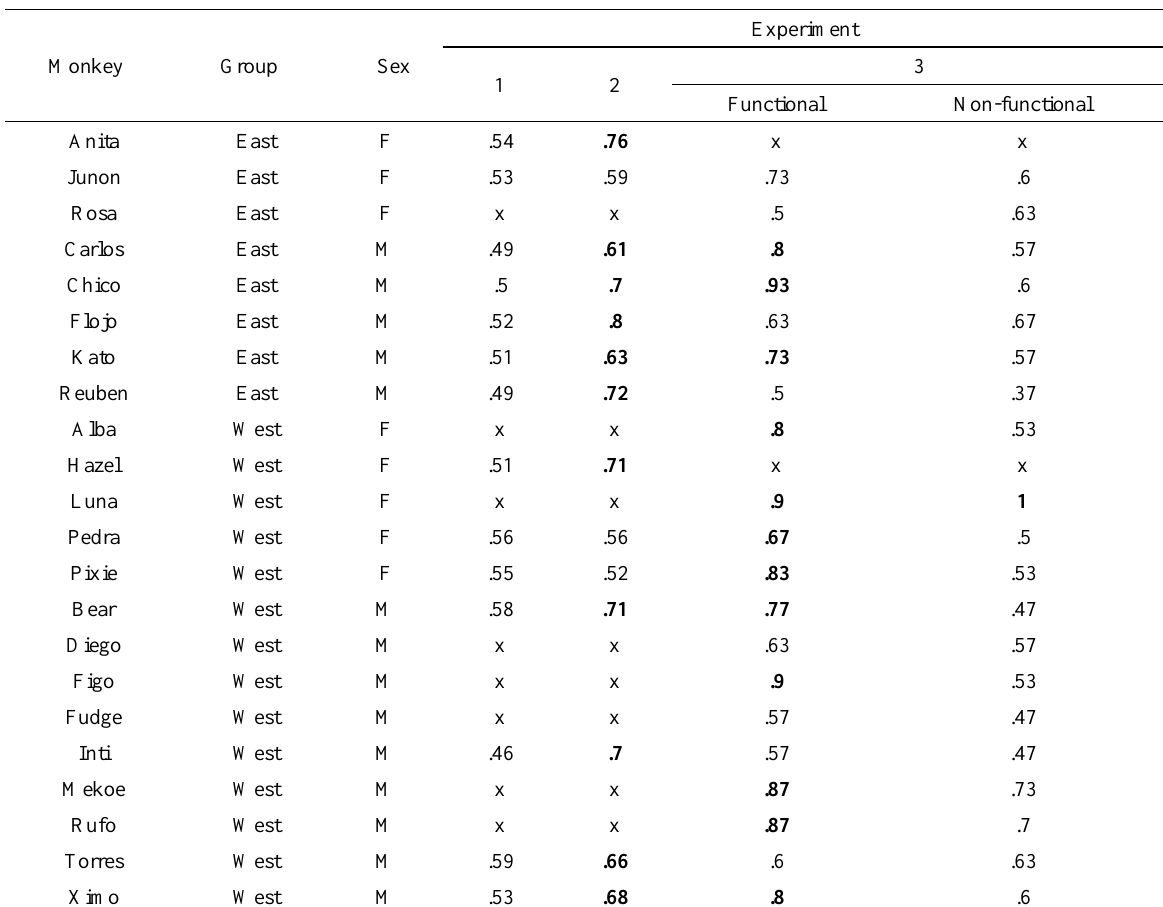
Capuchin Monkey Participants’ Details and the Experiments in which They